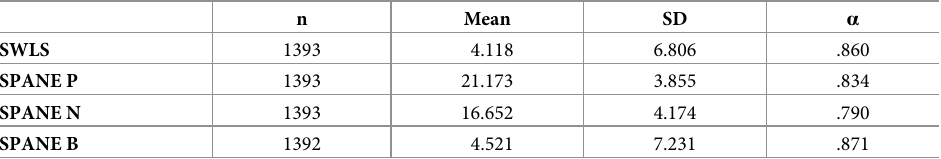
Table 2. Summary scale statistics.